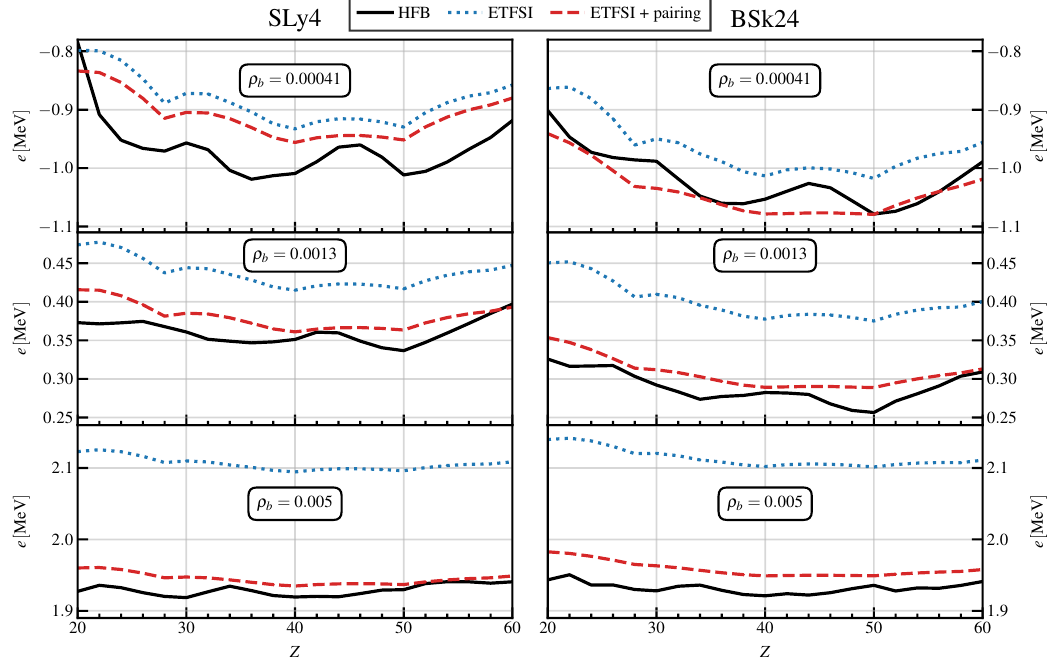
Figure 5. Selected slices of the energy surface at fixed baryonic densities ρ b , showing the variation of e with Z . Black solid lines show the HFB results, blue dotted lines the ETFSI results and the red dashed lines the results for ETFSI with neutron and proton pairing included. Results with the SLy4 functional (with strong pairing) are shown in the left column, and those with BSk24 are shown in the right column. The HFB calculations use the optimum values of R WS found with the ETFSI+pairing